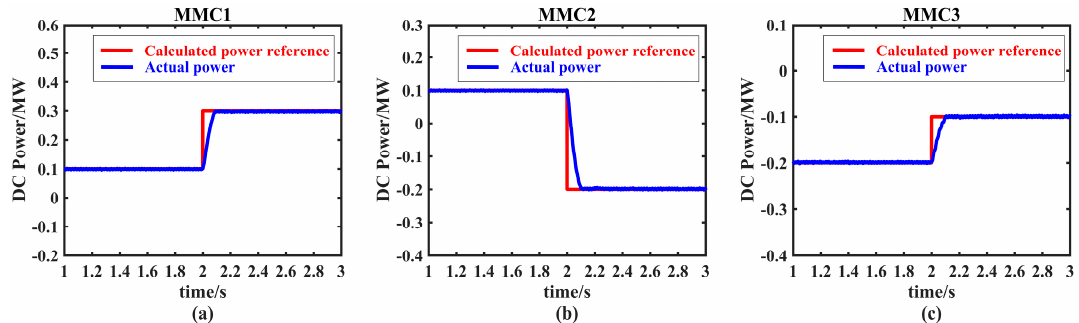
Figure 11. Calculated and actual power of the MMCs. ( a ) MMC1; ( b ) MMC2; ( c ) MMC3.